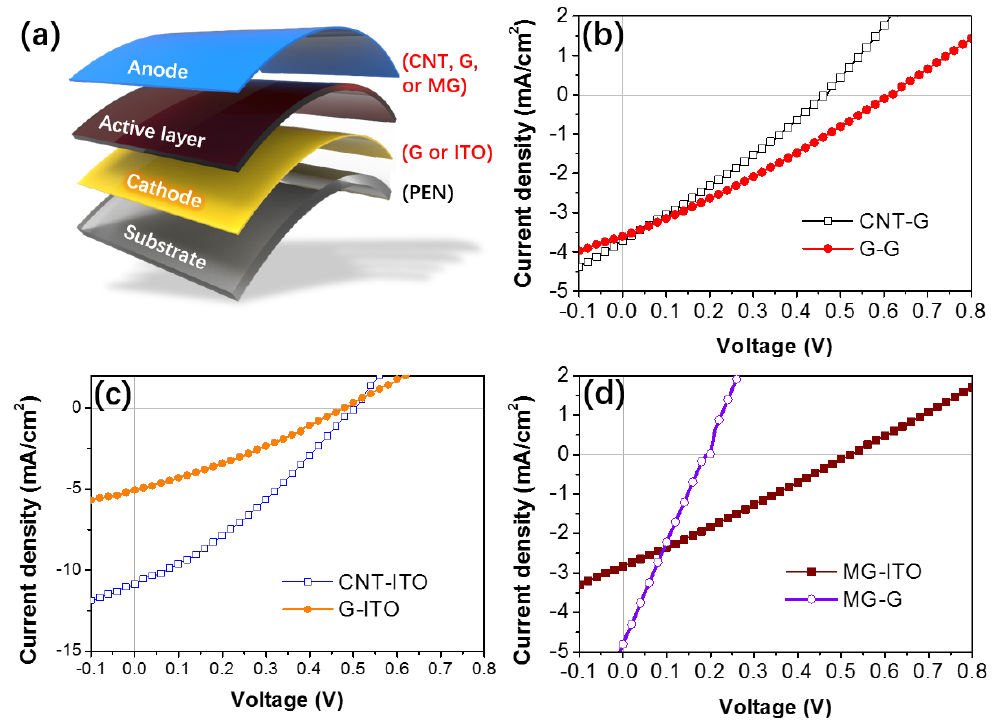
Figure 4. ( a ) Schematic illustration of flexible solar cell devices with all-carbon electrodes and their indium tin oxide (ITO) analogues; ( b ) J–V characteristics of solar cells with CNT (or G) as the anode and G as the cathode; ( c ) J–V characteristics of control devices using ITO as the cathode and CNT (or G) as the anode; ( d ) J–V characteristics of solar cells with MG as the anode and G (or ITO) as the cathode. Here “G” and “MG” denote few-layer graphene films and multi-layer graphene films,